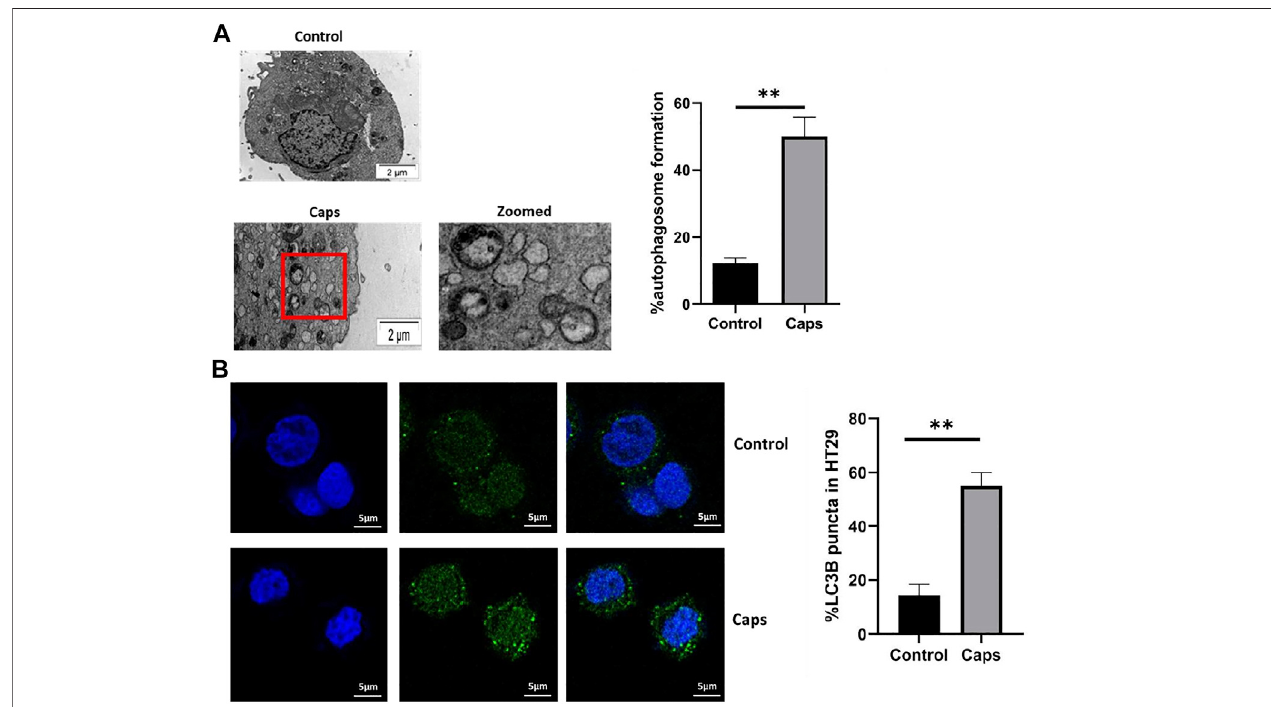
FIGURE 3 | Treatment with Caps enhances autophagosome formation. (A) Electron microscopic (TEM) pictures showed the presence of autophagosome formation in control and Caps-treated HT-29 cells for 4 h. Zoomed images of the marked area. Scale bar: 2 μ m. Graphical representation of % autophagosome formationasobservedinTEM.Unpaired t -testwasperformed. (B) ConfocalmicroscopicimagesofGFP-LC3Btransfectedintestinalcells(HT-29)showedLC3Bpuncta (green) formation. Brie fl y, cells were transfected with GFP-LC3B plasmid, then treated with Caps for 4 h, and visualized under a confocal microscope. Graph representingthepercentageofLC3Bpunctaformation.Allexperimentswereperformedintriplicate.Unpaired t -testwasperformed.GraphsgeneratedusingGraphPad Prism 5 were represented as mean ± SEM (n = 3); signi fi cance was calculated; * p < 0.05, ** p < 0.01, *** p <